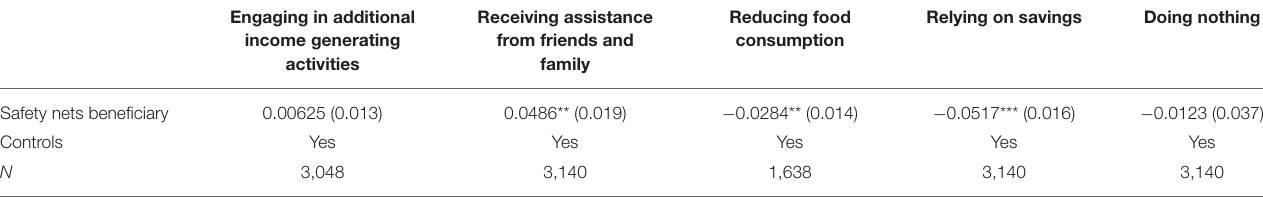
TABLE 9 | Female head regression results on safety